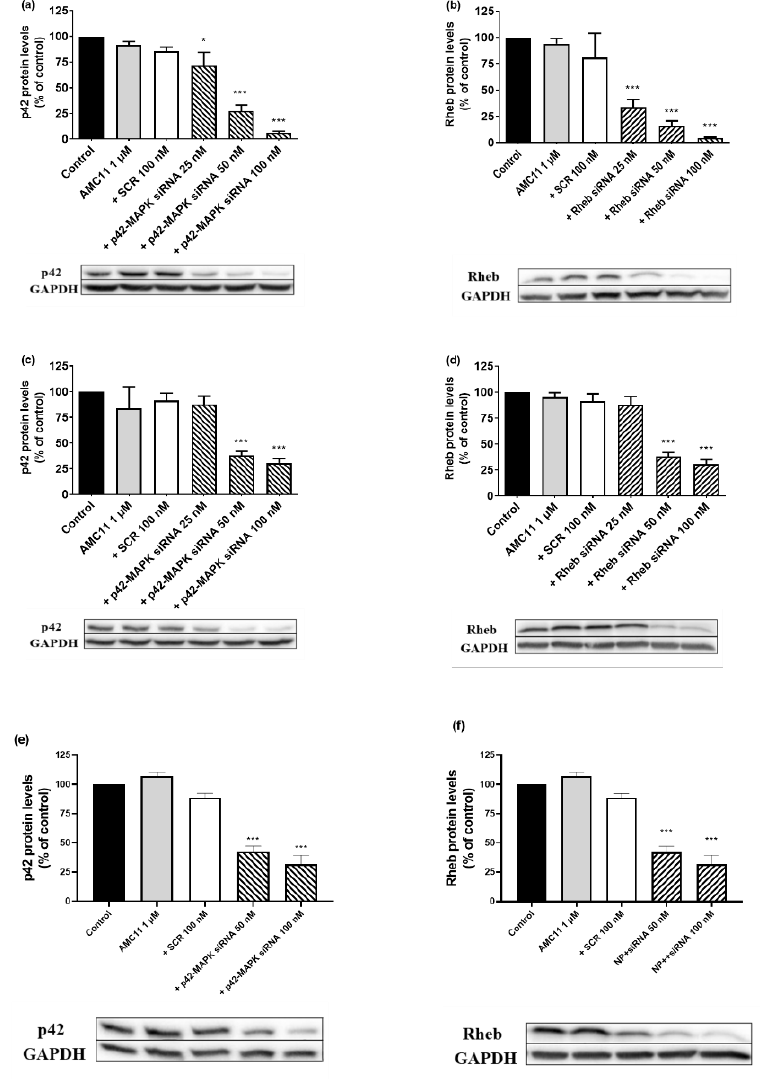
Figure 4. Transfection efficiency of AMC11 in LNCaP, PC3, and astrocytes. ( a ) p42-MAPK protein levels in LNCaP cells, ( b ) Rheb protein levels in LNCaP cells, ( c ) p42-MAPK protein levels in PC3 cells, ( d ) Rheb protein levels in PC3 cells, ( e ) p42-MAPK protein levels in rat astrocytes, and ( f ) Rheb protein levels in rat astrocytes. Cells were exposed for 72 h to the indicated treatments and the specific protein levels determined as indicated in Materials and Methods. Western blot bands show representative experiments for each experimental condition. Data represent mean ± SEM of 5 to 8 experiments: * p < 0.05, *** p < 0.001 as compared to control